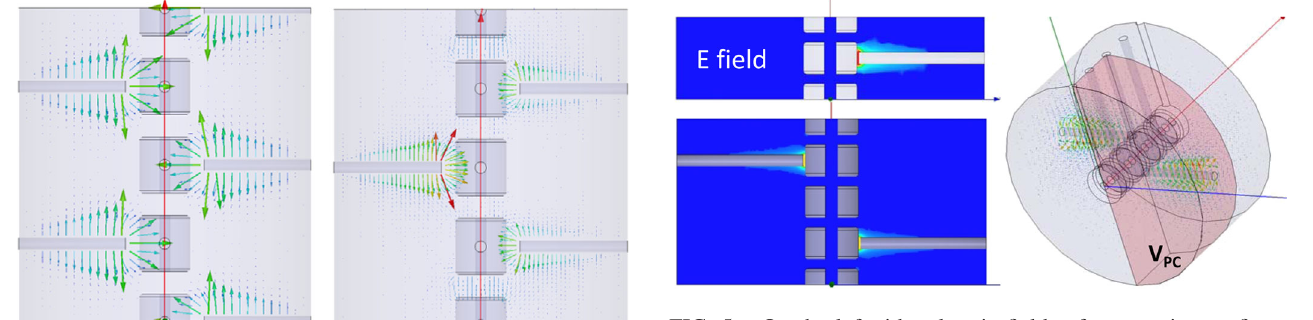
, used for the PC of the inductor L . p eq